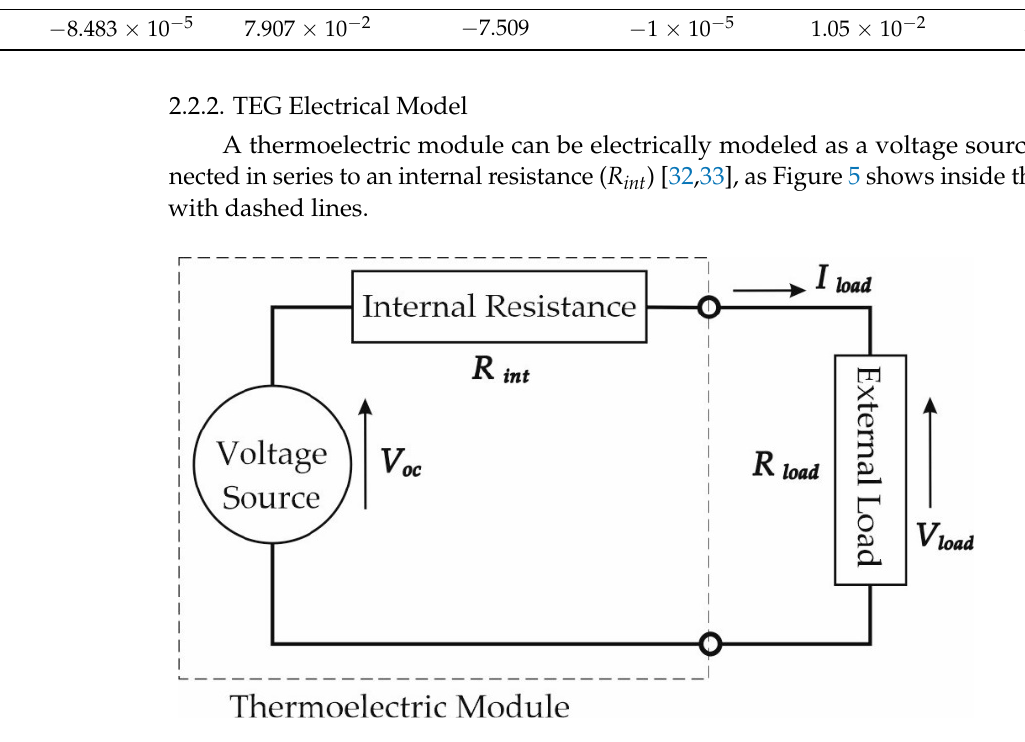
Figure 5. Electrical model of thermoelectric module.